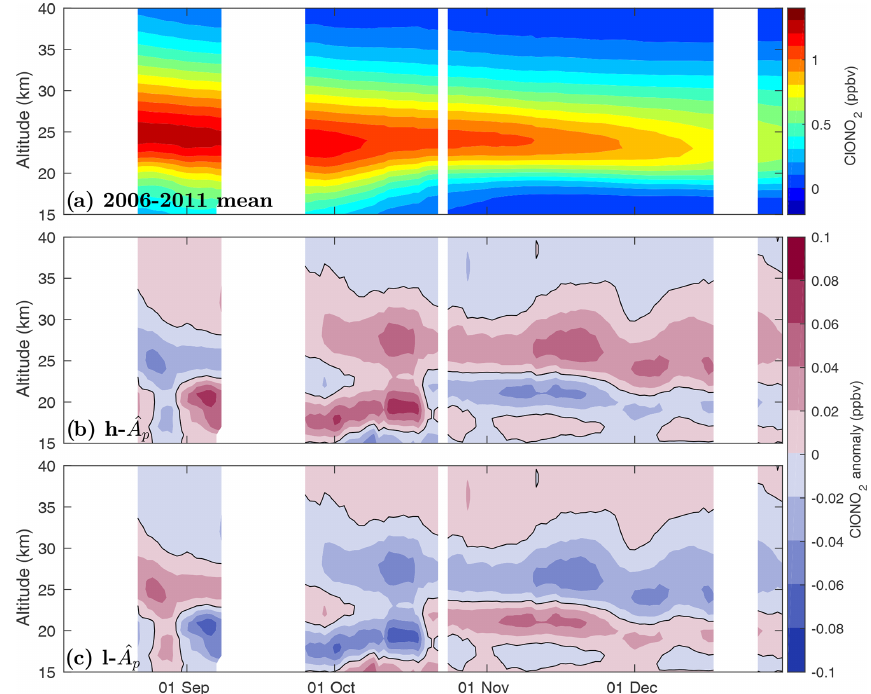
Figure 10. (a) Composite mean of area-weighted MIPAS ClONO 2 averaged over 60–90 ◦ S from 2006 to 2011. The y axis is the altitude range from 15 to 40km ( ∼ 120–2hPa), and the x axis is the time from early August until the end of December. The contour interval is 0.1ppbv. (b) Anomaly for the composite mean of years with high (cid:99) Ap. The axes are the same as for panel (a) , and the contour interval is 0.01 ppbv. Panel (c) is the same as panel (b) but for years with low (cid:99) Ap.